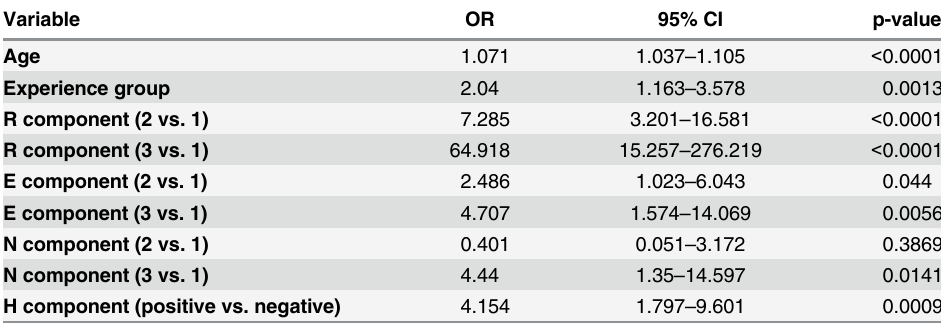
Table 4. Logistic regression analysis of factors affecting surgical decision making (radical nephrec- tomy vs. partial